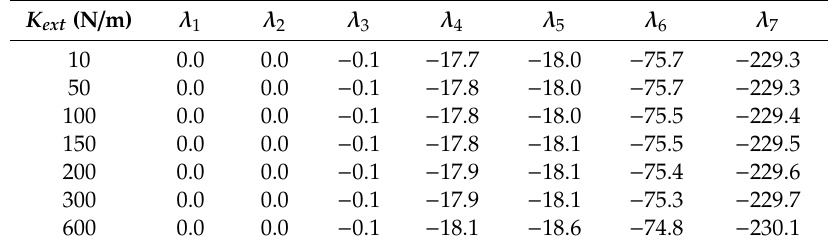
. Figure 5. Time evolution of λ 6 𝛌𝛌 𝟔𝟔